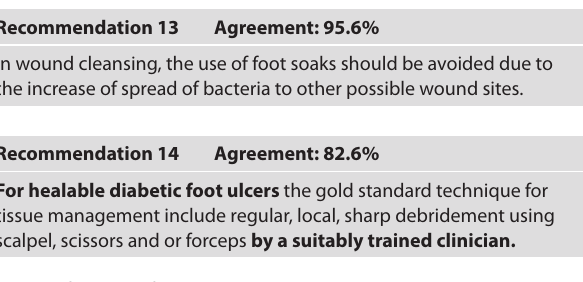
Cleanse wounds with low toxicity solutions